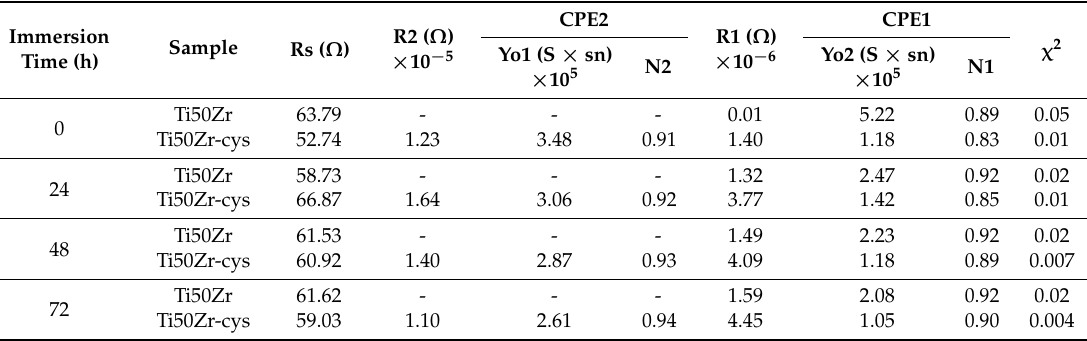
Table 2. The fitting values of the equivalent circuit elements for substrate and coated samples.